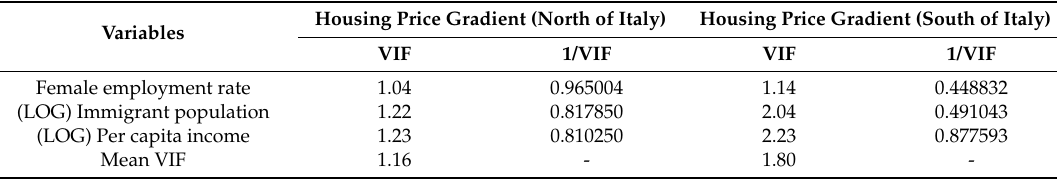
Table 6. Estimation of the variance inflation